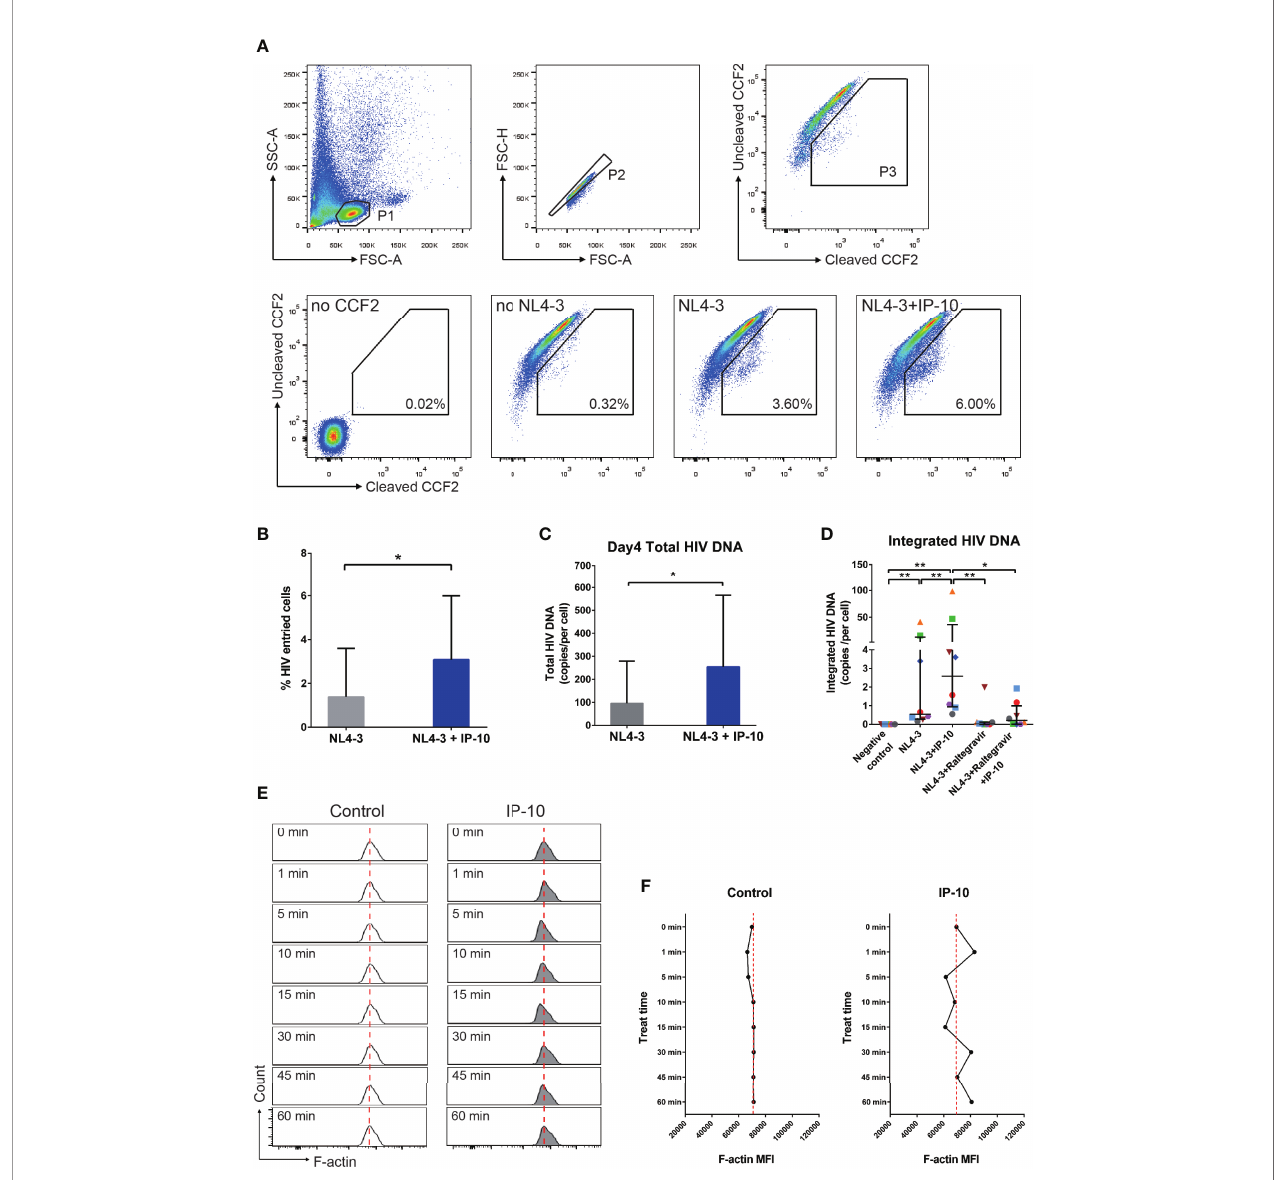
FIGURE 5 | IP-10 promotes HIV NL4-3 entry into resting memory CD4 + T cells, viral DNA synthesis and integration, and actin activation. (A) Gating strategy and representative fl ow cytometry plots from the experiment evaluating the role of IP-10 in the infection of resting memory CD4+ T cells by HIV NL4-3. Viral entry into resting memory CD4+ T cells was evaluated with the BlaM-Vpr entry assay. For no CCF2 , cells were pretreated for 1 h with IP-10 (5 ng/ml) and then infected with NL4-3. For no NL4-3 , cells were treated with CCF2 without NL4-3 infection. For NL4-3 , cells were treated with CCF2 before infection with NL4-3. For NL4-3+IP-10 , cells were treated with CCF2 before pretreatment for 1 h with IP-10 (5 ng/ml), and then infected with NL4-3. The Wilcoxon matched-pairs test was used to compare median values between two groups (N=7, P =0.016). (B) Quanti fi cation of HIV+ cells in NL4-3 and NL4-3+IP-10 groups. The Wilcoxon matched-pairs test was used to compare median values between groups. (C) For NL4-3 , cells were infected with NL4-3; for NL4-3+IP-10 , cells were pretreated for 1 h with IP-10 (5 ng/ml) and then infected with NL4-3. Cells were infected for 2 h, washed, and then collected at different time points for ddPCR quanti fi cation of total viral DNA at 4 days. Results are expressed as copies/cell. The Wilcoxon matched-pairs test was used to compare median values between groups (N=6, P =0.031). (D) Quantitative (Alu) PCR analysis of HIV DNA integration in negative control, NL4-3, NL4-3+IP-10, NL4-3+raltegravir, and NL4-3+raltegravir+IP-10 groups. As the variances are different, the Wilcoxon matched-pairs test was used to compare median values between groups (N=8, NL4-3 vs. NC: P =0.008; NL4-3+IP-10 vs . NC: P =0.008; NL4-3+IP-10 vs . NL4-3: P =0.008; NL4-3+Raltegravir vs . NL4-3+IP-10: P =0.008; NL4-3+Raltegravir +IP-10 vs. NL4-3+IP-10: P =0.039; NL4-3+Raltegravir vs. NC: P =0.062; NL4- 3+Raltegravir +IP-10 vs . NC: P =0.016; NL4-3+Raltegravir vs. NL4-3: P =0.078; NL4-3+Raltegravir+IP-10 vs. NL4-3+Raltegravir: P =0.469). (E) Representative fl ow cytometry plots from the experiment evaluating the effect of IP-10 on actin polymerization and depolymerization over time. The red dashed line represents localized baseline unstimulated F-actin level. (F) Temporal pro fi le of MFI in control and IP-10 – treated resting memory CD4 + T cells (The result for one of the three separated experiments is showed in the fi gure). * P < 0.05, ** P <